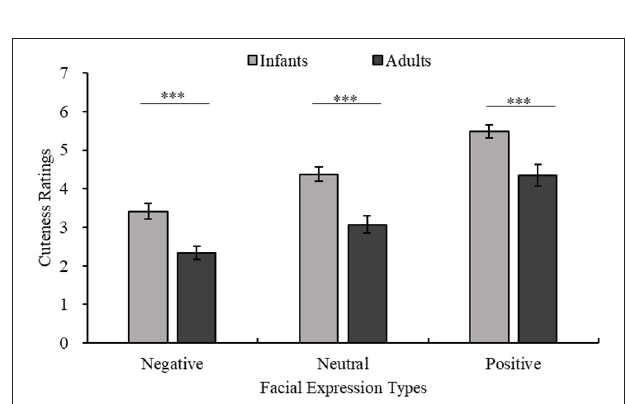
FIGURE 6 | Ratings for the cuteness of infants and adults with the same eye size. The horizontal axis shows three eye sizes and cuteness ratings are shown on the vertical axis. The light color shows the infant stimuli, and the dark color shows the adult stimuli. Adults > infants for the same eye size, all *** p < 0.001.